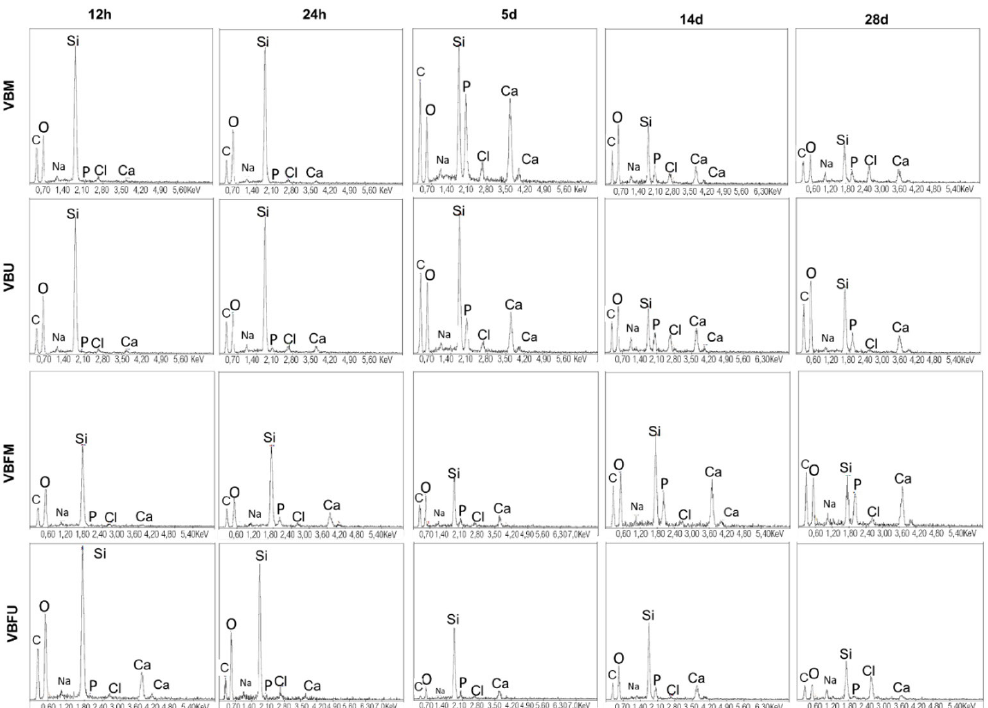
Figure 8. EDS spectra of the surfaces of the BGM, BGU, BGFM and BGFU after incubation in SBF for 12 h, 24 h, 5 d, 14 d and 28 d.